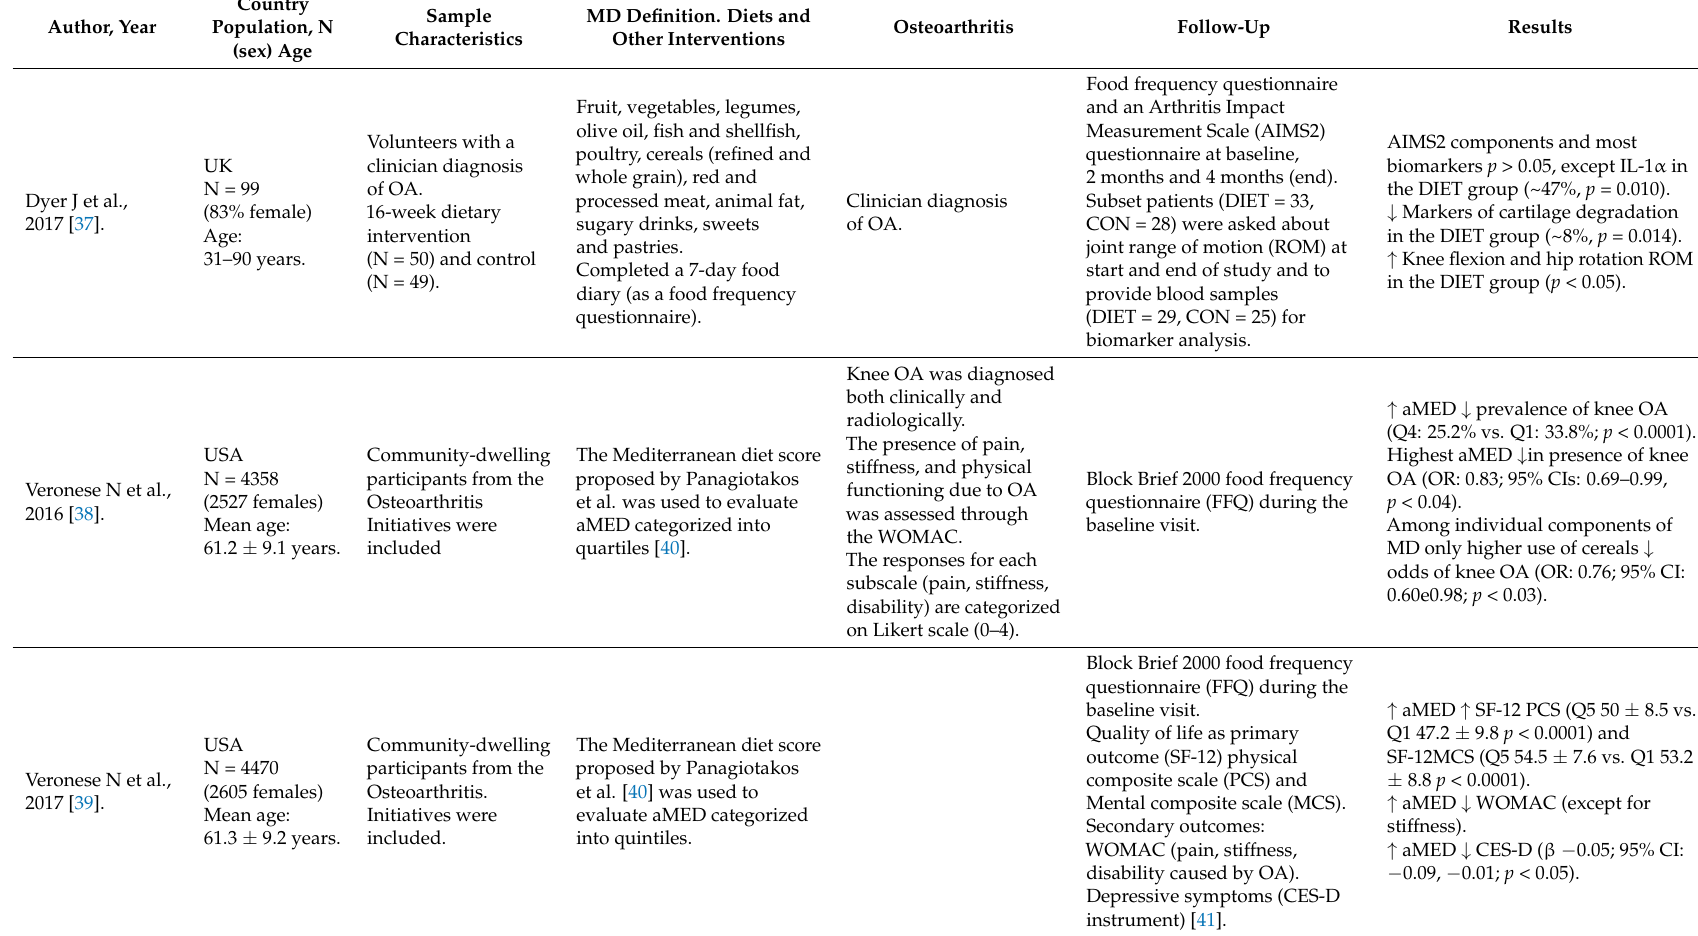
Table 1. Epidemiological studies on mediterranean diet and